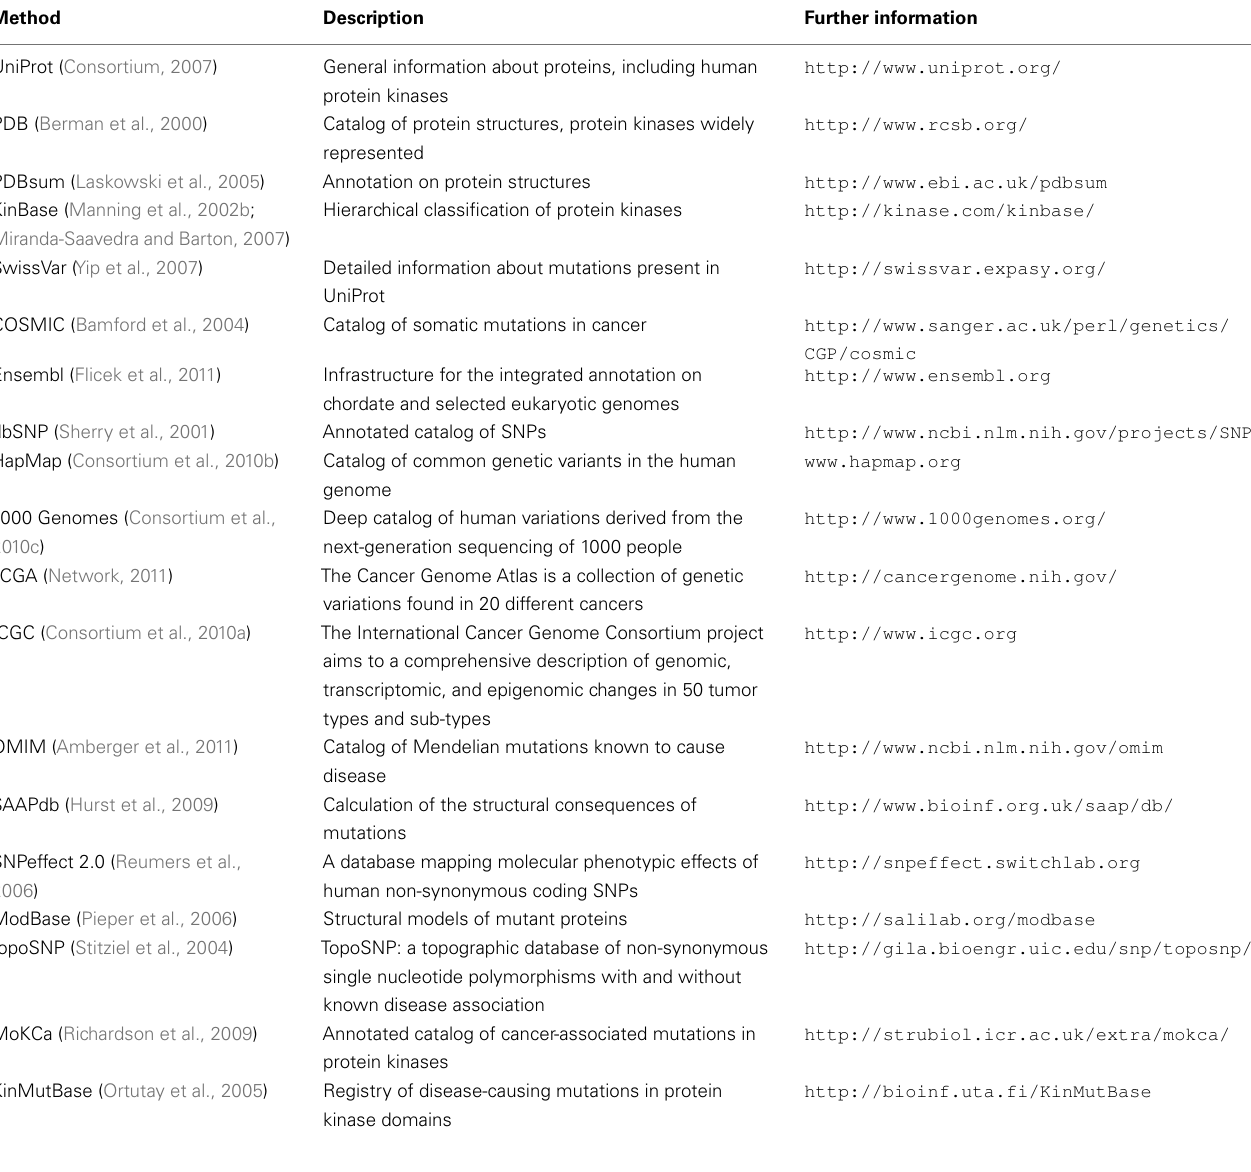
Table 2 | Summary of resources providing information about kinases and mutations. Method